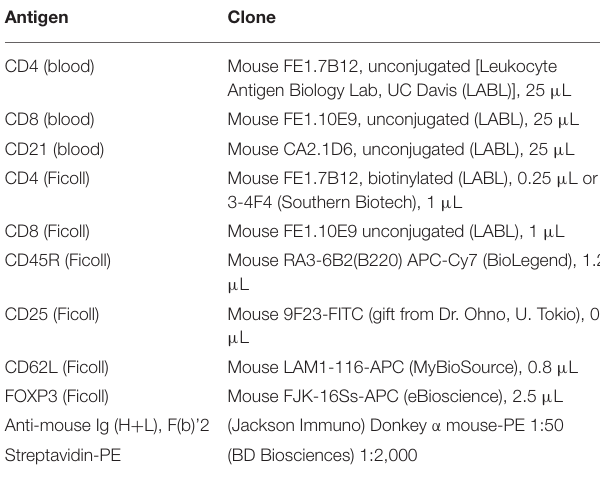
TABLE 2 | Flow cytometry antibodies, clones, and